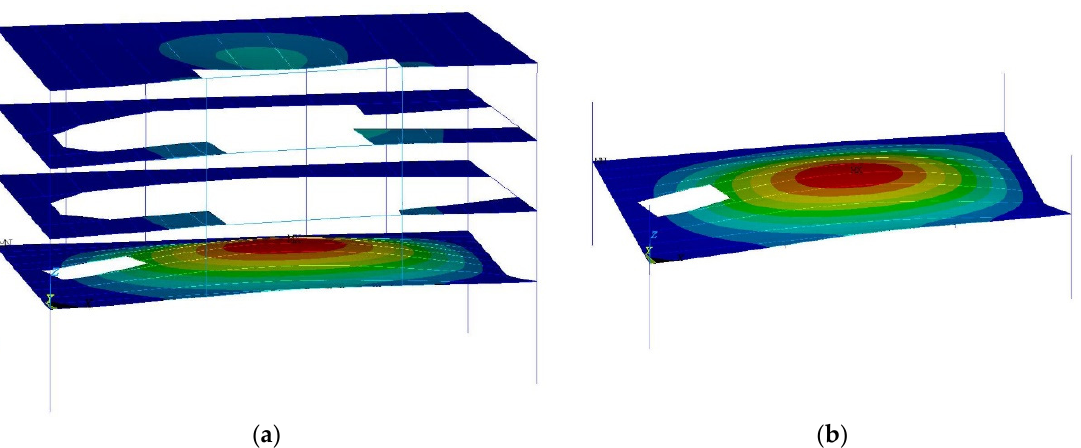
Figure 10. Mode shapes of the suspended floor predicted with the two FE models: ( a ) overall FE model; ( b ) local equivalent FE model.